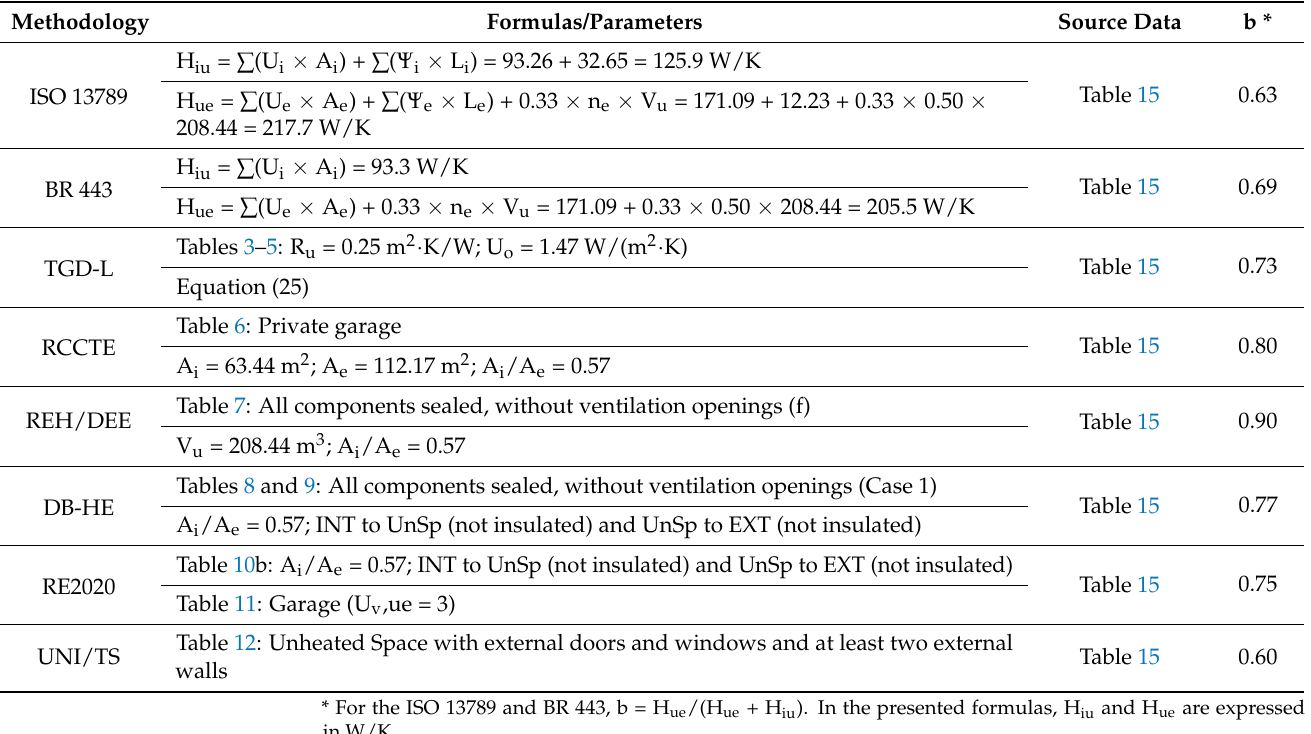
Table 19. Values of the estimated adjustment factor (b) for Garage 1.